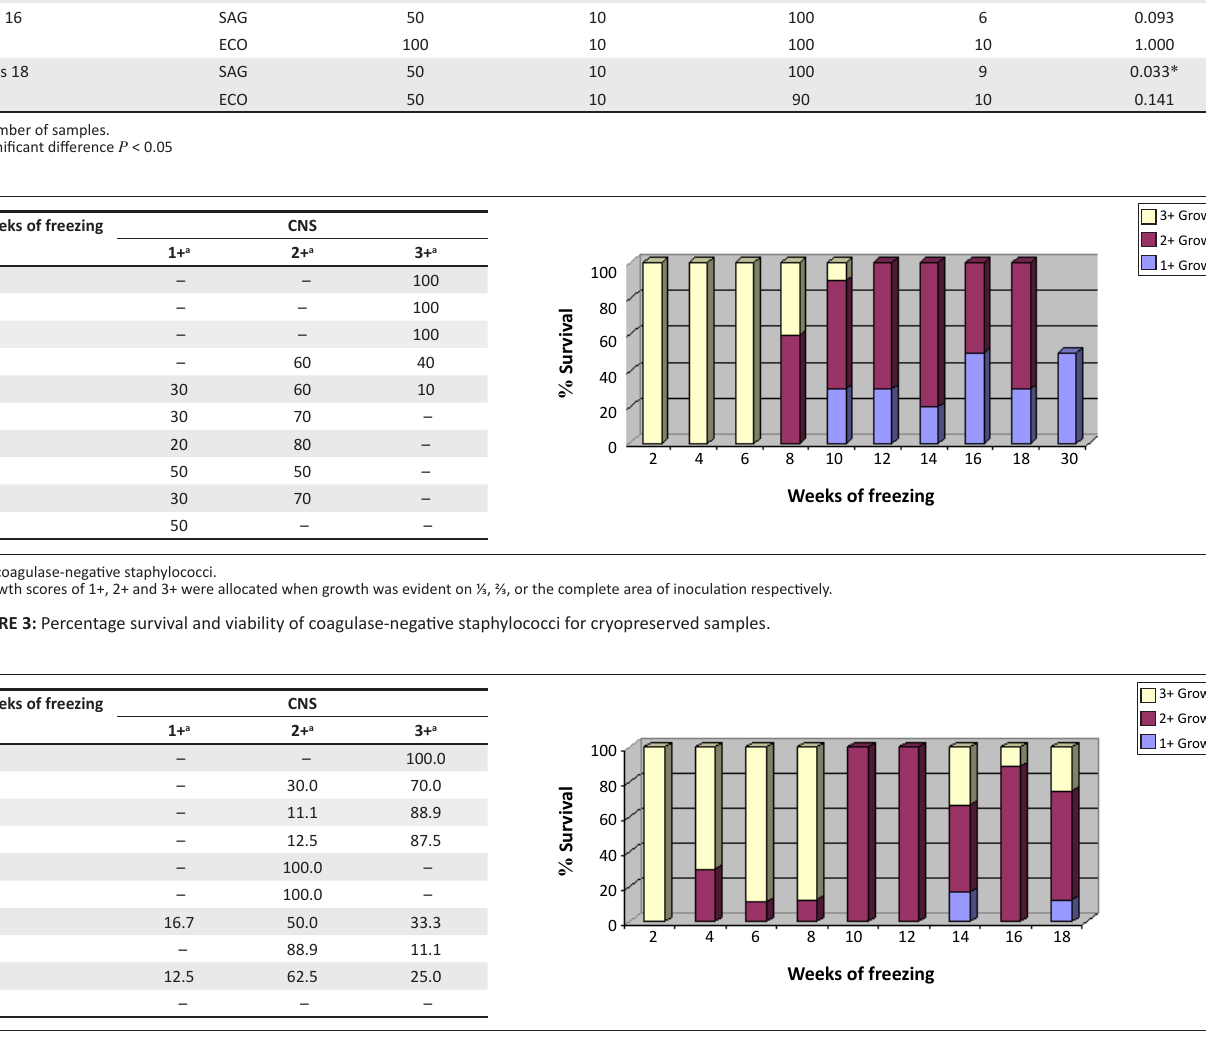
FIGURE 4: Percentage survival and viability of coagulase-negative staphylococci for frozen